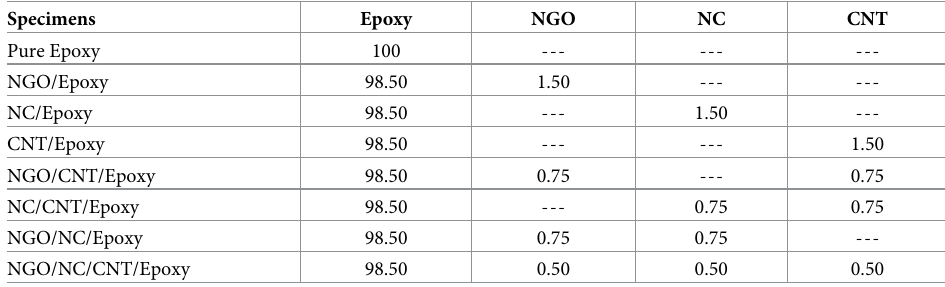
Table 1. The weight percentage of different nanostructured fillers used in